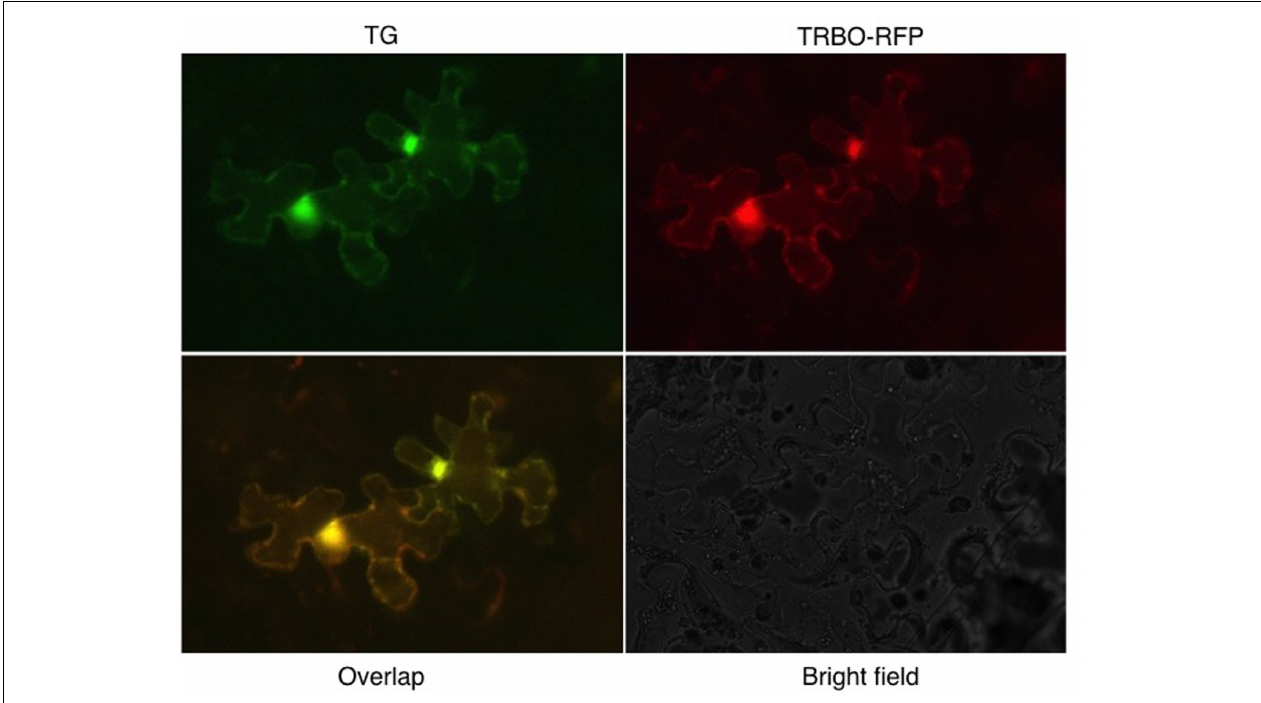
FIGURE 7 | TG and TRBO-RFP co-agroinfiltrated on 4-week old N. benthamiana . Plant epidermal cells were observed 10 days after infiltration. Fluorescence occurs throughout the cytoplasm and the bright spots probably reflect accumulation of fluorescent components in the cytoplasm surrounding the